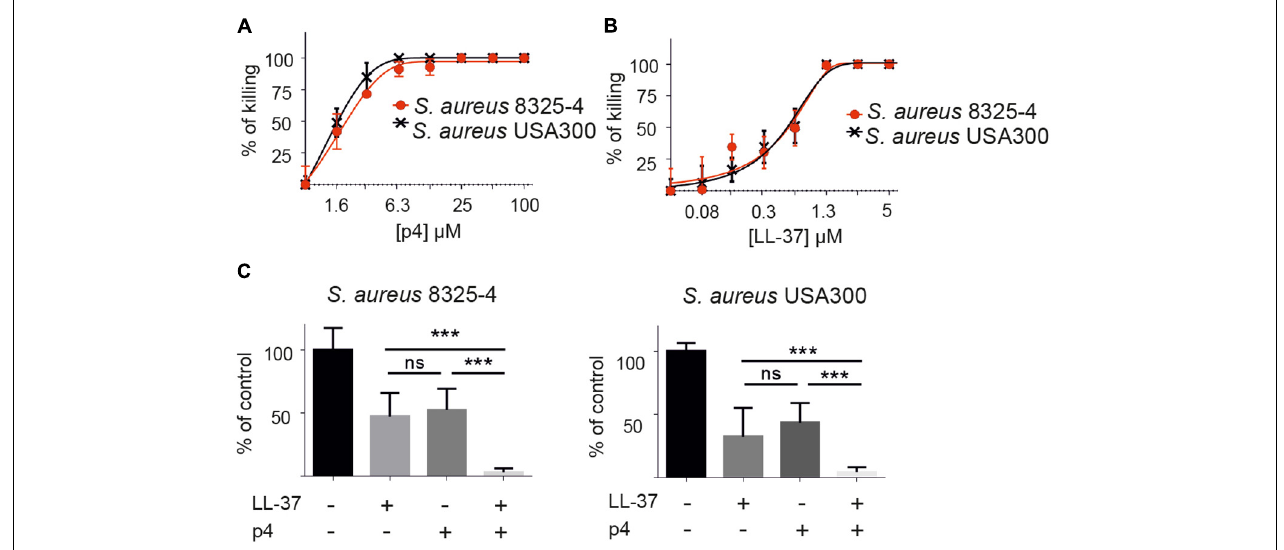
FIGURE 1 | p4 is bactericidal in vitro against different strains of S. aureus and collaborates additively with peptide LL-37 in restricting S. aureus growth. (A) S. aureus strains 8325-4 and USA300 were incubated with the indicated concentration of p4 for 2 h. Cell viability in CFU/ml, shown as the percentage of killing for the indicated strain, was analyzed by MDA assay. (B) The indicated S. aureus strains were incubated with the indicated concentration of LL-37 for 2 h. Cell viability in CFU/ml, shown as the percentage of killing for the indicated strain, was analyzed by MDA assay. (C) The indicated S. aureus strains were incubated with 1.6 µ M p4 and/or 0.6 µ M LL-37 for 2 h. Cell viability in CFU/ml, shown as the percentage of control cells (bacteria incubated with PBS), was analyzed by MDA assay. Results are expressed as the mean ± SD of three independent experiments. *** p < 0.0001, ns, non-significant by one-way ANOVA with post hoc Tukey’s multiple comparison